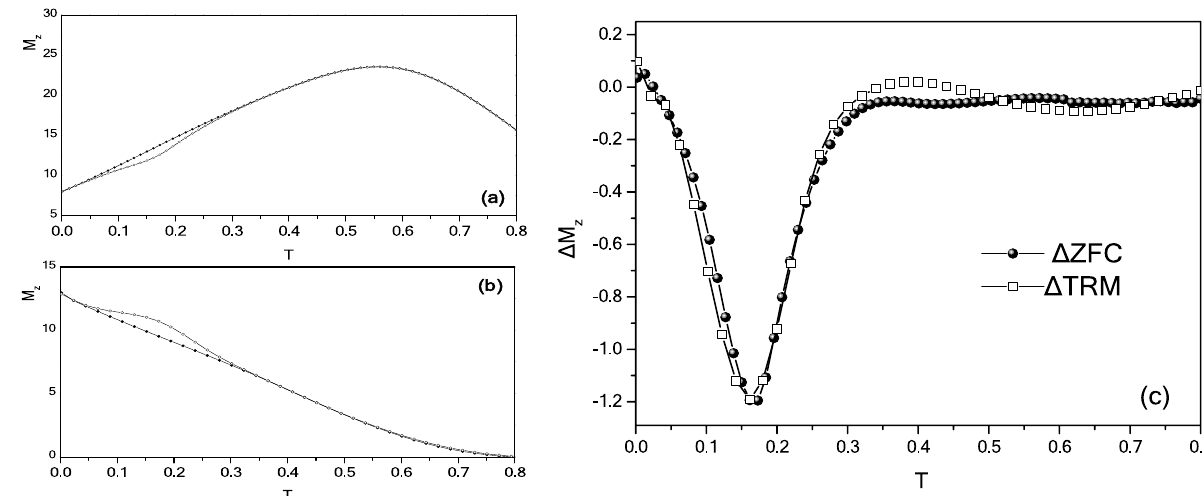
Figure 4. ( a ) Monte Carlo simulations of the ZFC ( a ) and TRM ( b ) magnetizations at H=0.08. Two curves ZFC and TRM calculated after a t w = 5*10 6 MCSS stop at T = 0.18 while cooling are added; ( c ) difference with the corresponding reference